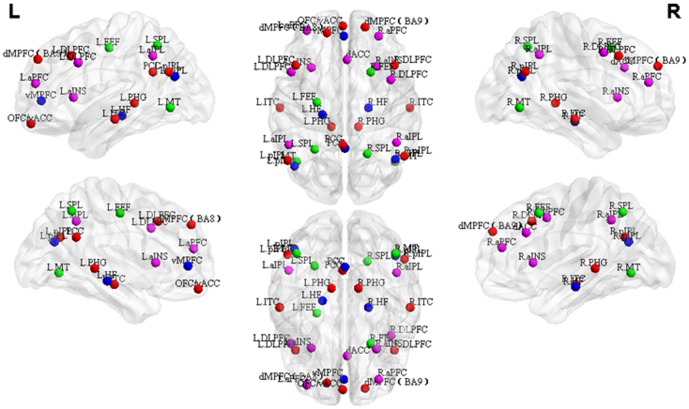
The spatial distributions of 33 ROIs from DMN, HCMN, DAN and FPCN.The coordinates of ROIs are shown in Table 2. The abbreviations are as described in the main text.